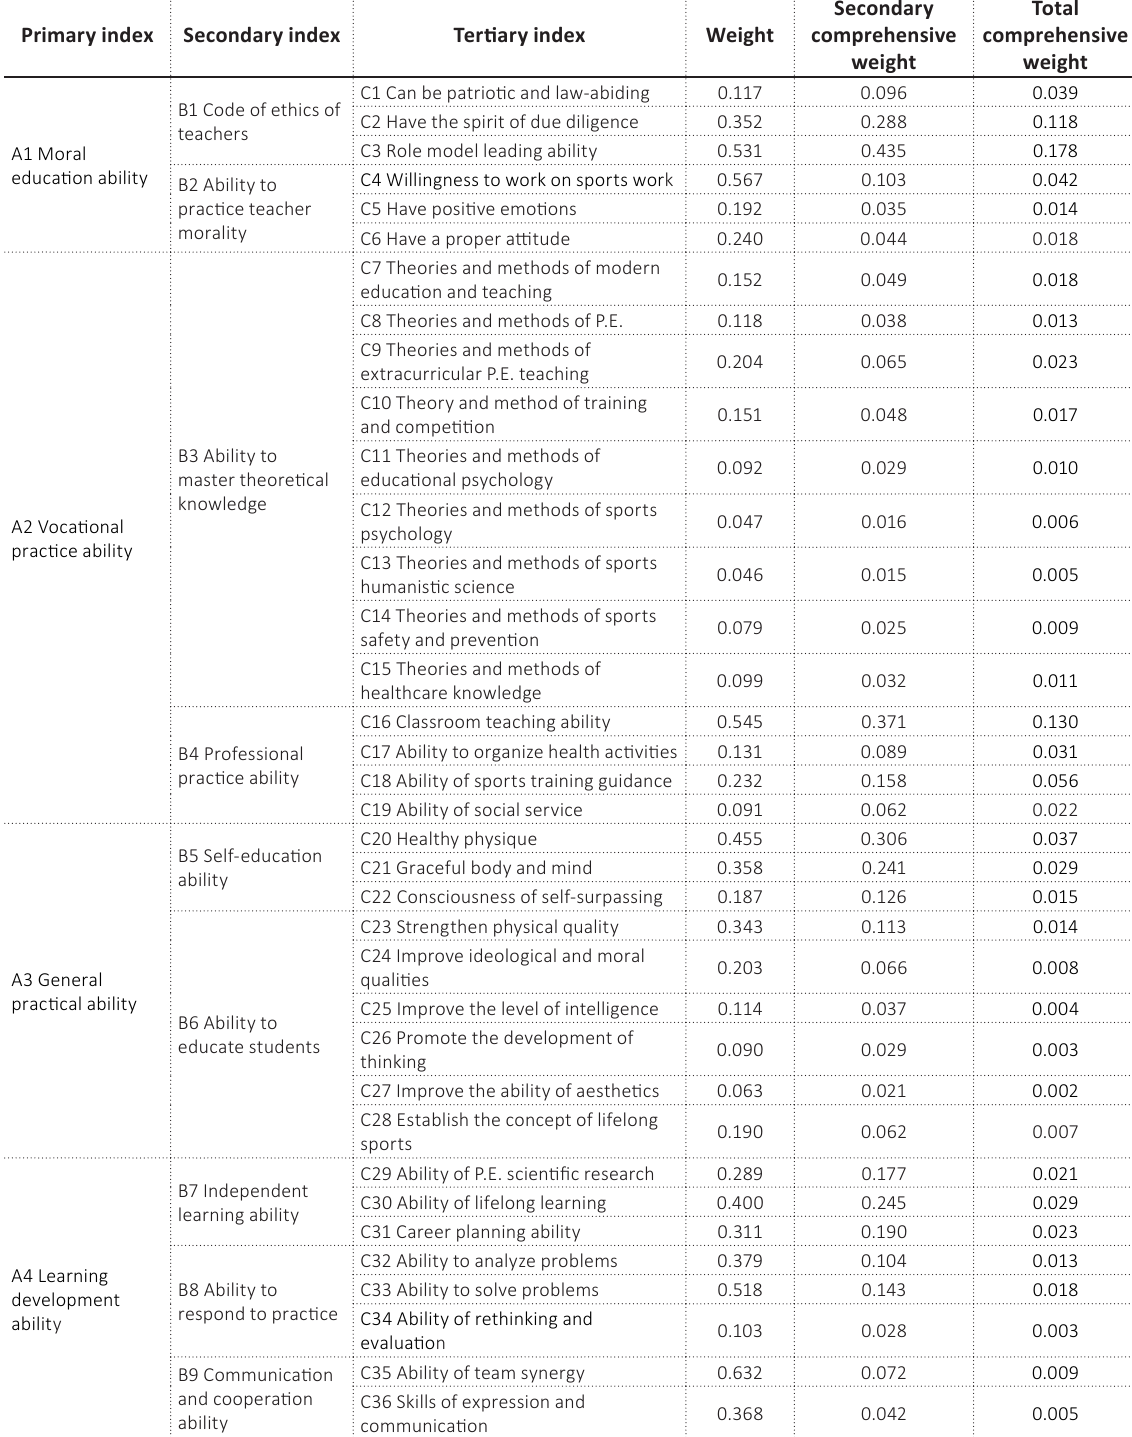
Table 7. Comprehensive weight of the third-level